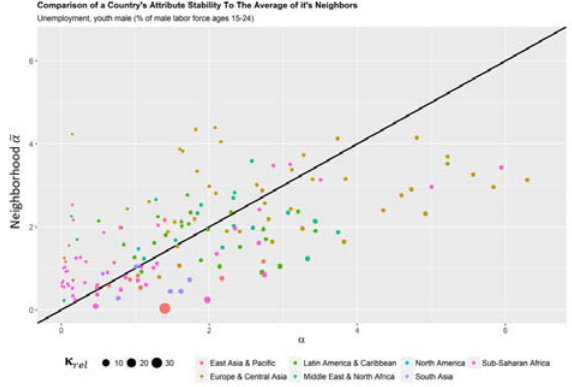
𝛼𝛼 𝑠𝑠𝑠𝑠 During the entire study period the rate of youth male